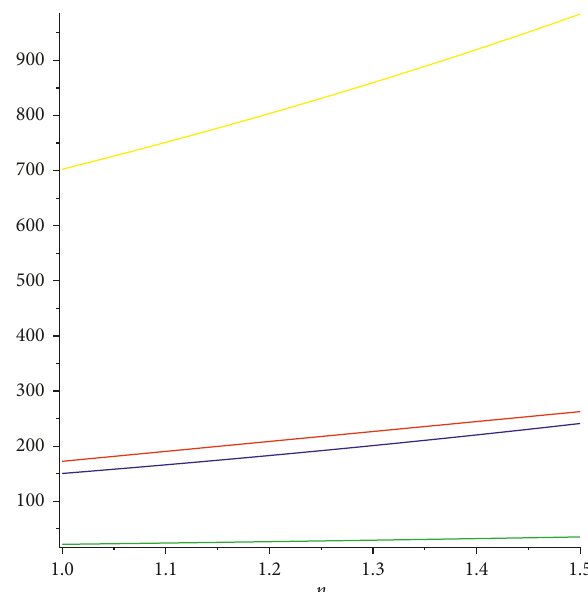
Figure 7: IR1 of D